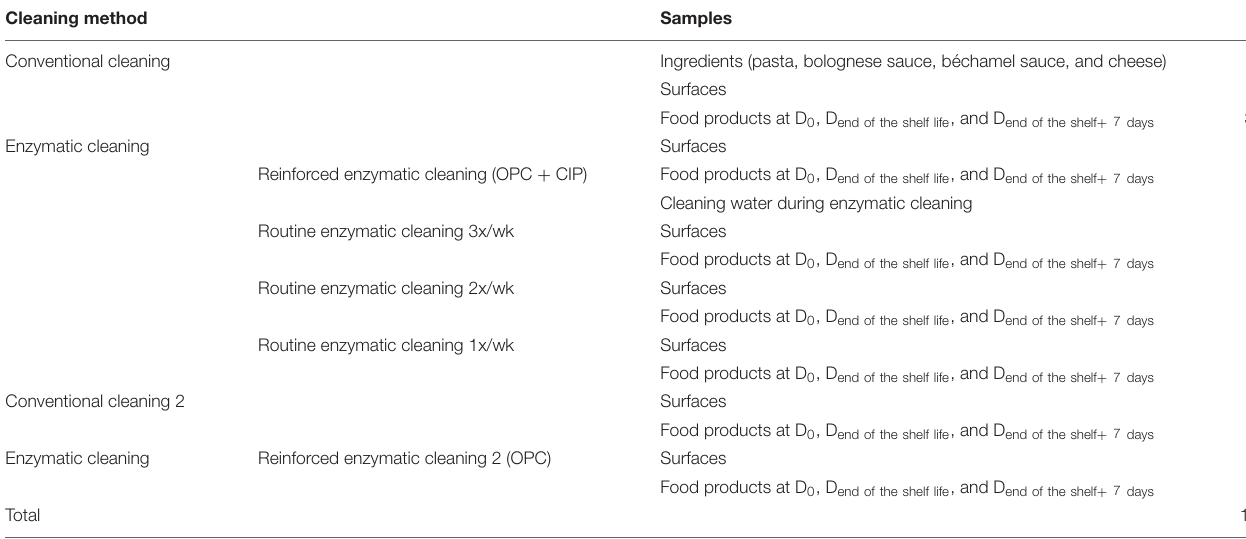
TABLE 2 | Samples analyzed by classical microbiology and metagenetic